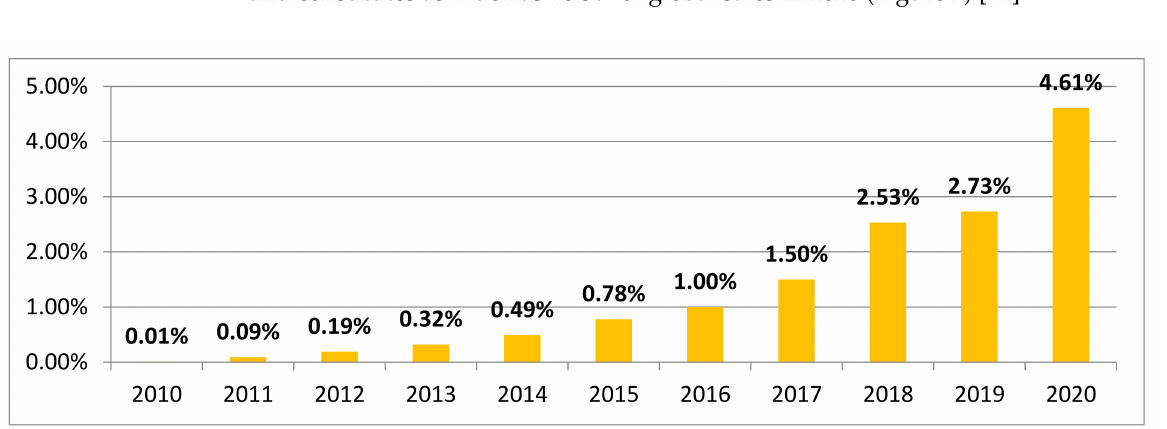
Figure 2. EV sales’ share among cars worldwide, 2010–2020. Source: https://www.iea.org/articles/global-ev-data-explorer (accessed on 10 October